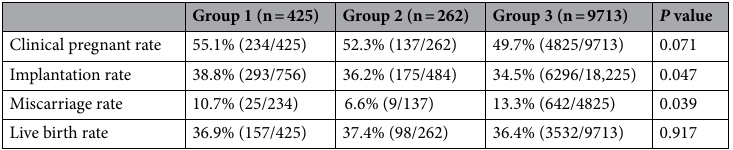
Table 3. Pregnant outcomes between three groups after IVF/ICSI-ET.